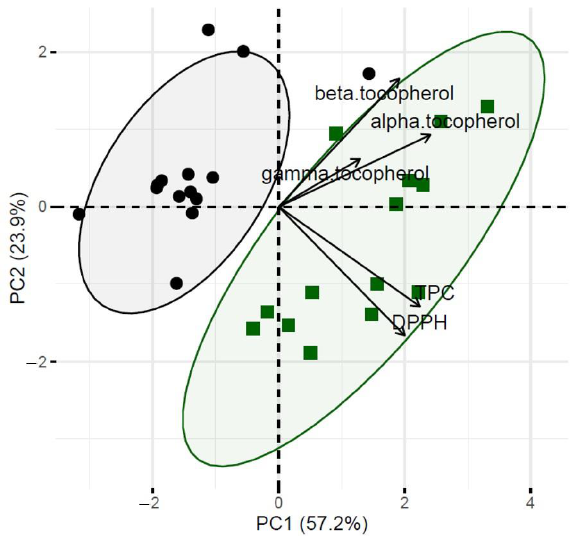
Figure 3. Differentiation of cv. Santulhana olives not subjected to frost ( ■ ) and subjected to frost ( ● ): 2D PCA biplot based on the tocopherols content ( α -, β - and γ -), total phenol content (TPC), and DPPH radical scavenging